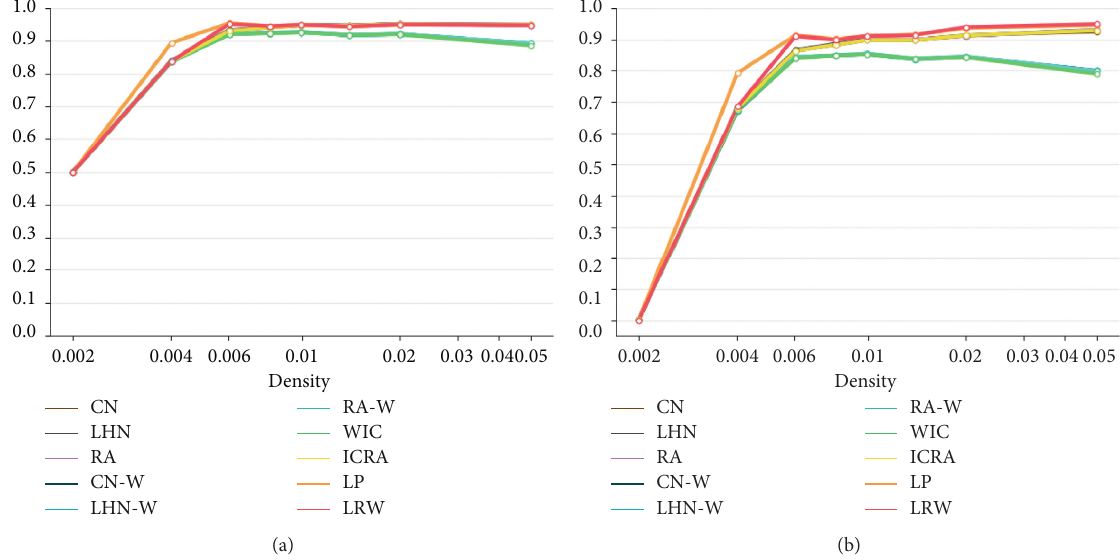
Figure 7: Performance of each predictor under AUC and W-index in WS-Group2. (a) Accuracy measured by AUC. (b) Accuracy measured by